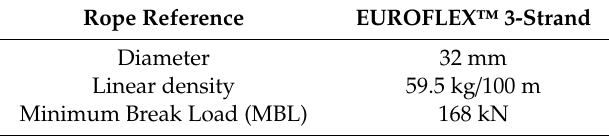
Figure 1. Twisted rope construction of the hybrid polyester-polyolefin rope. Table 1. Rope parameters provided by the manufacturer.